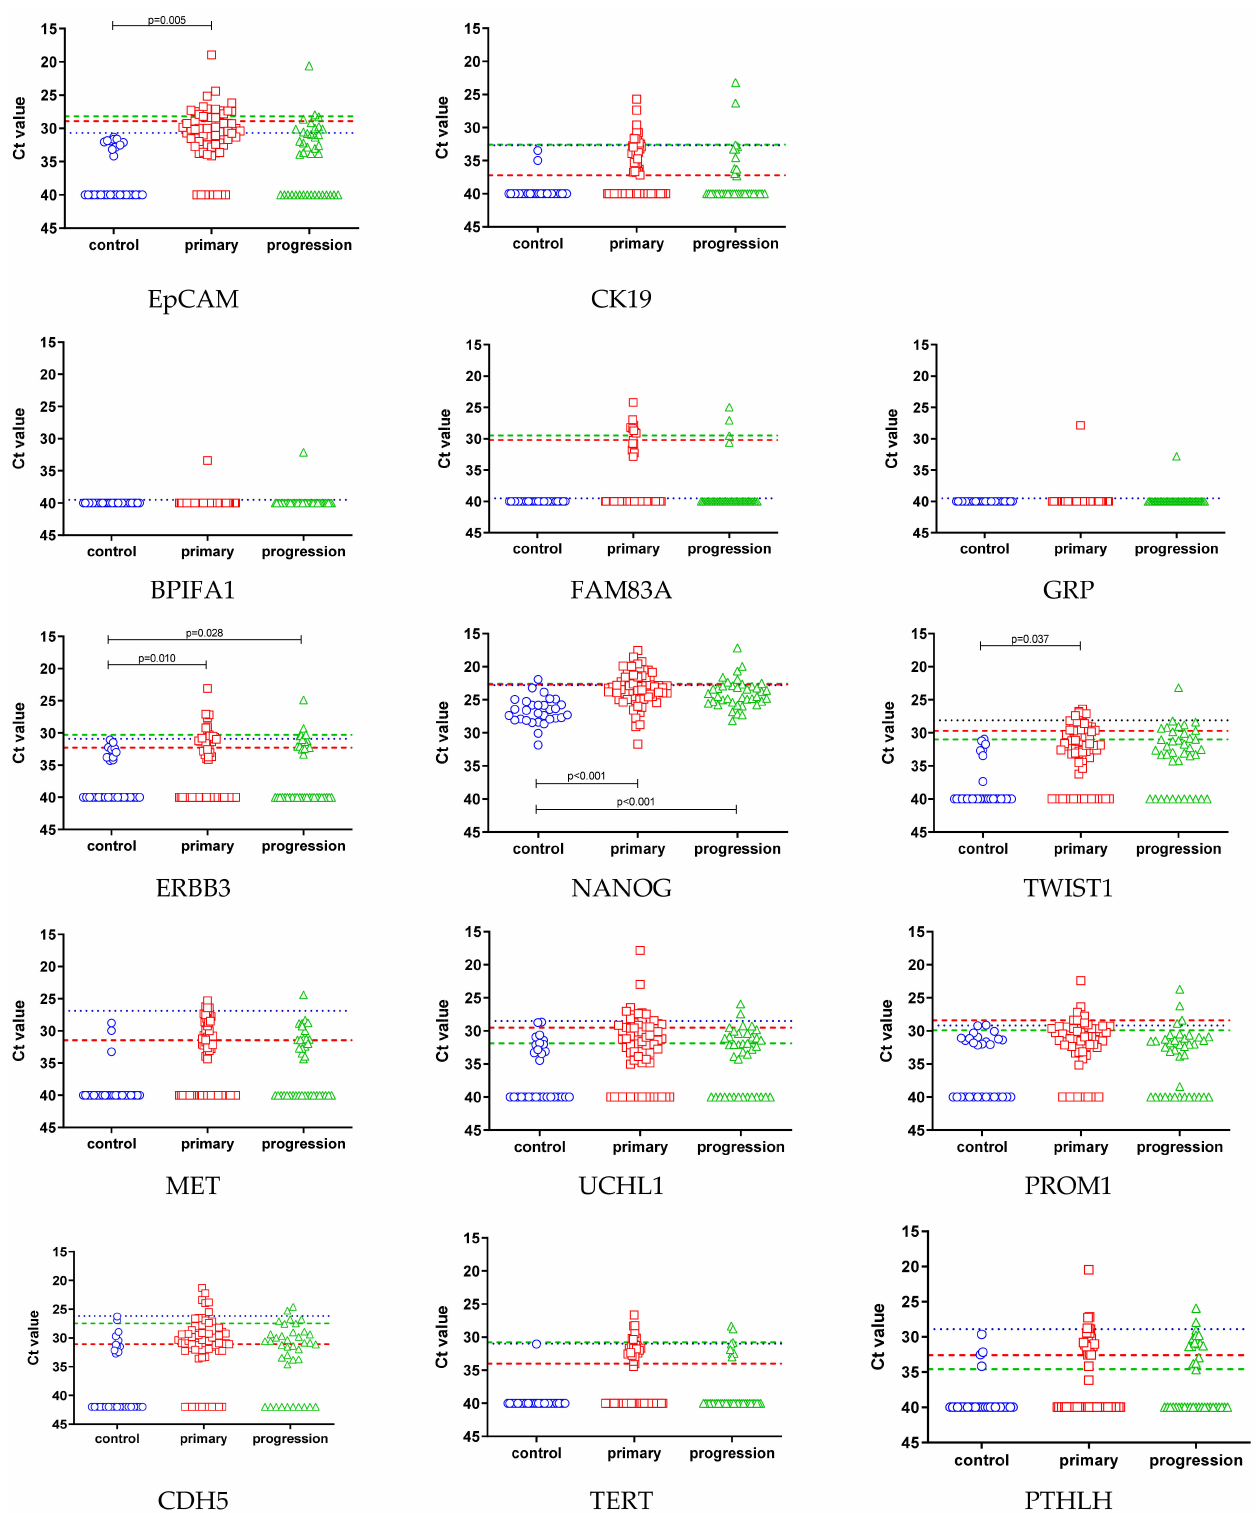
Figure 2. Mean Ct values of all the selected gene markers in the healthy donor blood samples ( n = 30) and in the NSCLC patient samples taken at both primary diagnosis ( n = 67) and progression ( n = 39). Absent gene expression levels are indicated by symbols corresponding to a Ct value of 40. Significantly different gene expression levels in healthy donor blood samples and each group of patient samples are indicated, and the respective p -value (ANOVA) is given. The diagnostic threshold levels are indicated by a dotted blue line. The prognostic thresholds of the primary and progression group are indicated by a red and green dashed line,